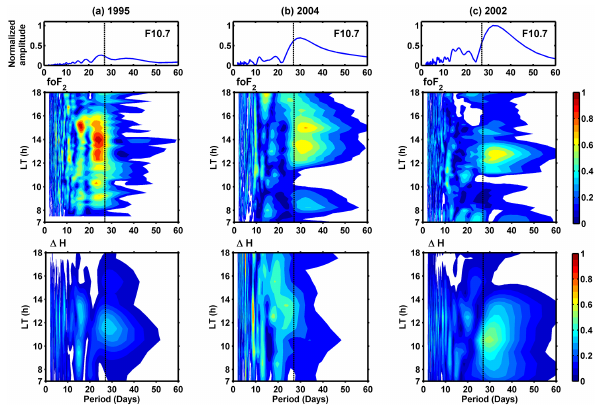
Figure 9. Spectral results, presented in terms of periods, of F 10 . 7 , f o F2 and (cid:49)H observations corresponding to (a) 1995 (LSA), (b) 2004 (MSA) and (c) 2002 (HSA). Data between day numbers 270 and 365 in each year, a period when continuous observations of f o F2 were available, have been used. Results on F 10 . 7 are obtained based on daily values, while those of f o F2 and (cid:49)H are based on daily values taken at a 1h interval during